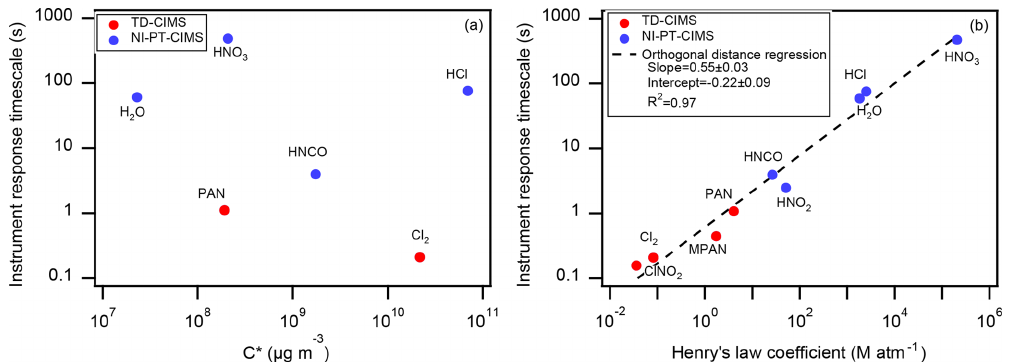
Figure 6. Instrument response timescales as a function of (a) saturation concentration and (b) Henry’s law coefficient for several inorganic compounds measured using TD-CIMS and NI-PT-CIMS. The dashed line is an orthogonal distance regression of the logarithm of the response timescale against the logarithm of the Henry’s law coefficient. Peroxyacetyl nitrate and peroxymethacryloyl nitrate are abbreviated as PAN and MPAN. No delay would be expected for these compounds due to partitioning to Teflon, as they all have C ∗ > 10 7 µgm − 3